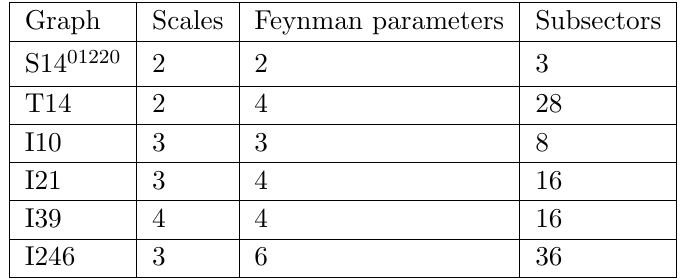
Table 2 . Properties of the integrals corresponding to the diagrams depicted in (cid:12)gure 1. The stated numbers of Feynman parameters correspond to the dimensionality of the expansion and integration steps of TayInt